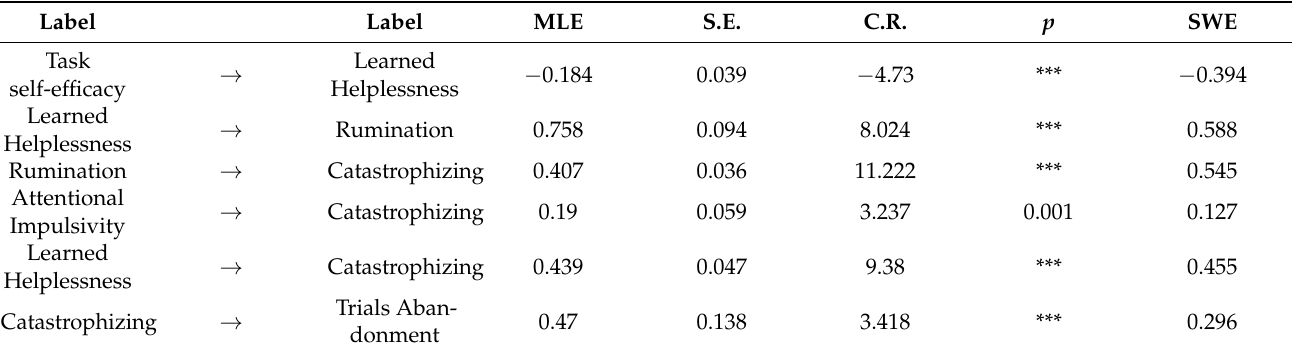
Table 3. Maximum likelihood estimates and standardized weight